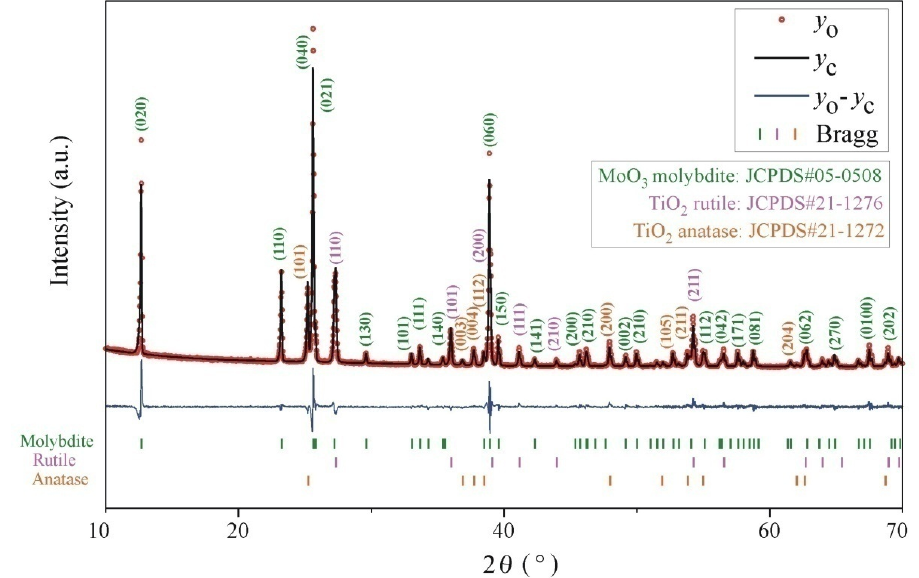
Figure 1. XRD pattern (the empty red dots) of TMO along with the Rietveld refinement profile (the solid black line) and the expected Bragg peak positions (the green, purple, and orange vertical bars) of the present phases. The blue curve shows the difference between the experimental and fitted results. Table 1. Rietveld refinement results of the TMO.